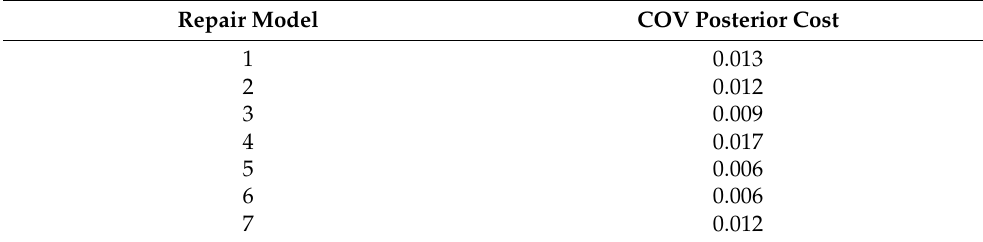
Table 7. COV of the posterior costs for the different repair